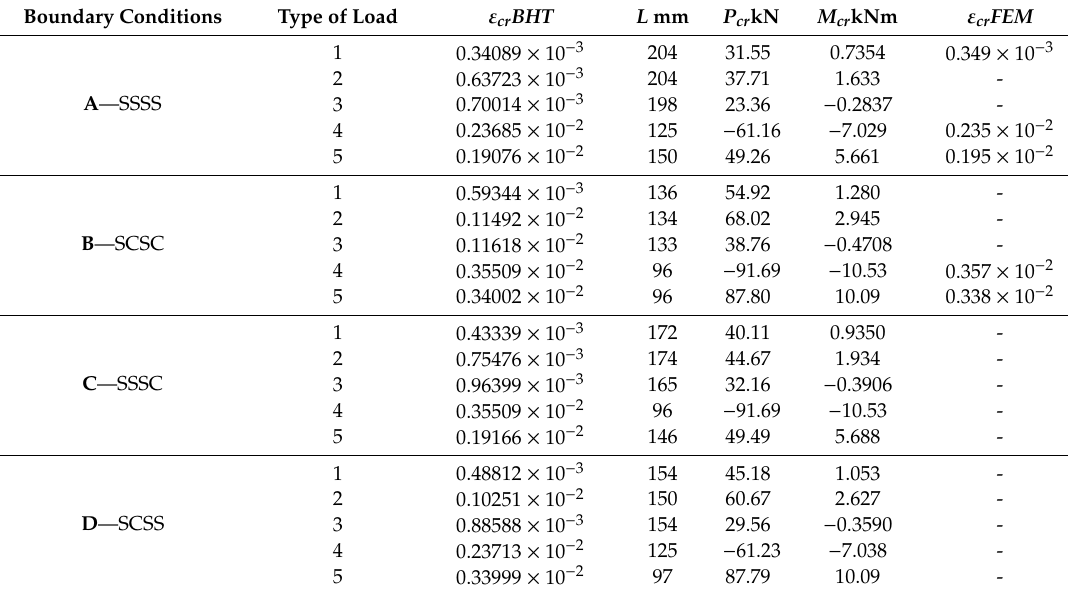
Table 2. Results of the lowest buckling